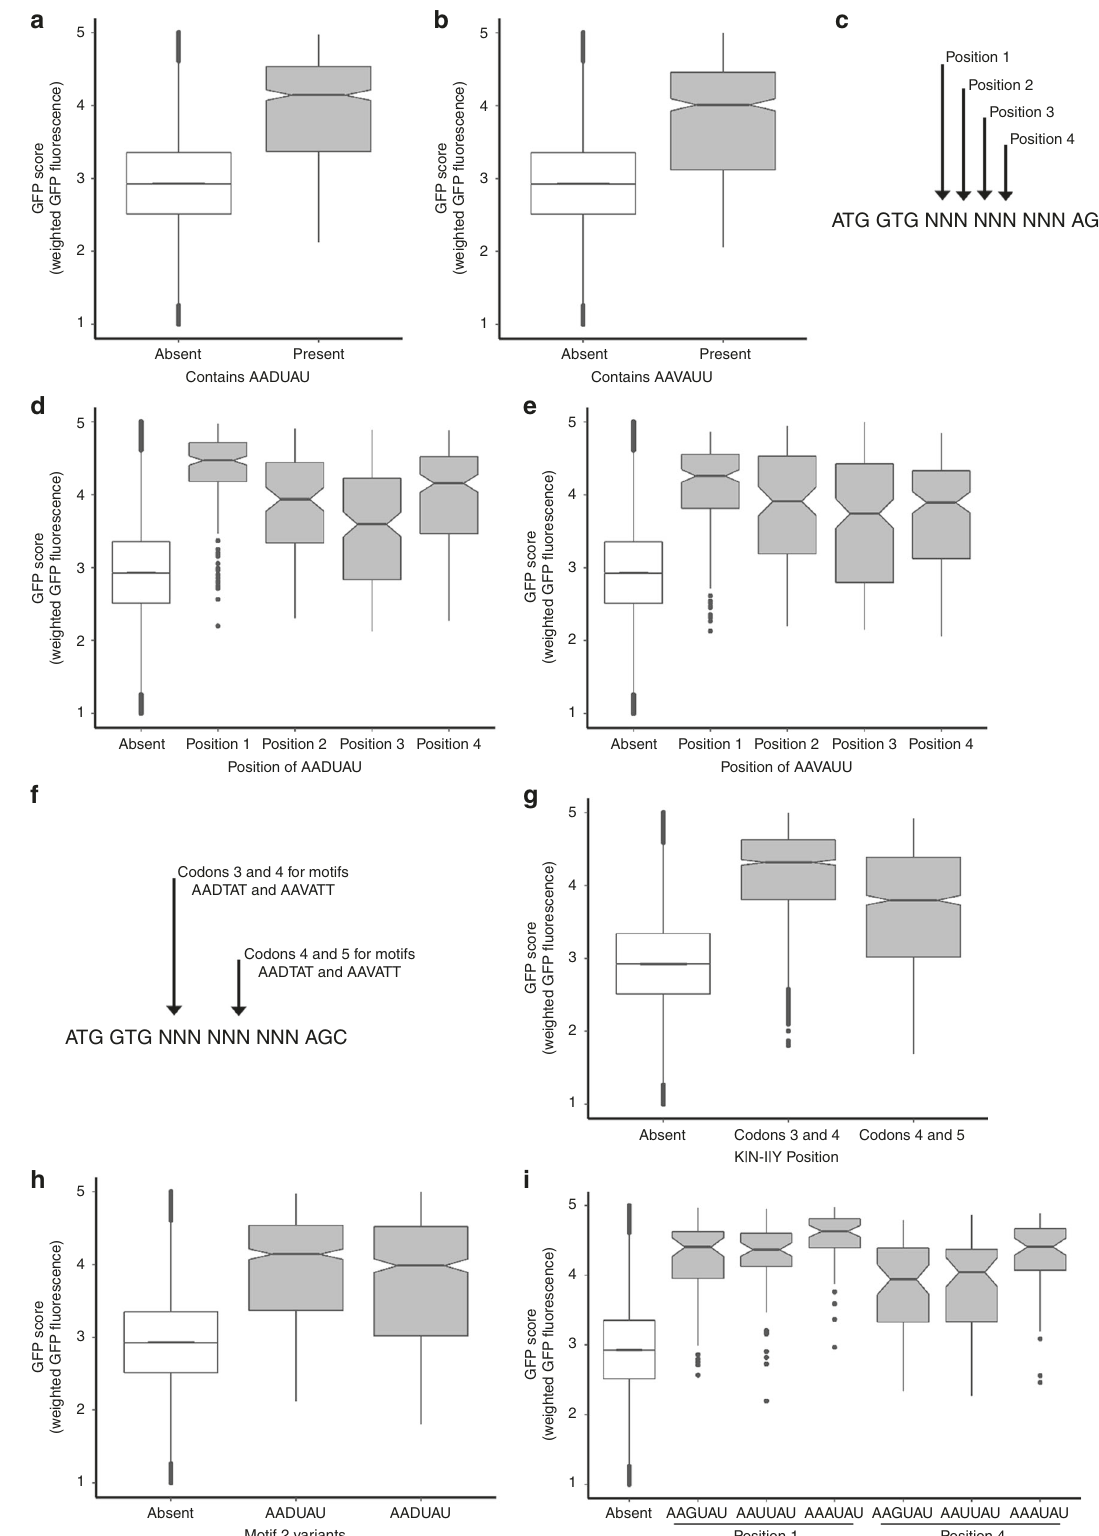
different vectors (Fig. 5b and Supplementary Fig. 18). In addition, the two vectors had different promoter, intergenic and ribosome binding (RBS) sequences close to the translation start site. Expression of mCherry reporter was uniform for all constructs regardless of the vector, while eGFP variants were expressed at